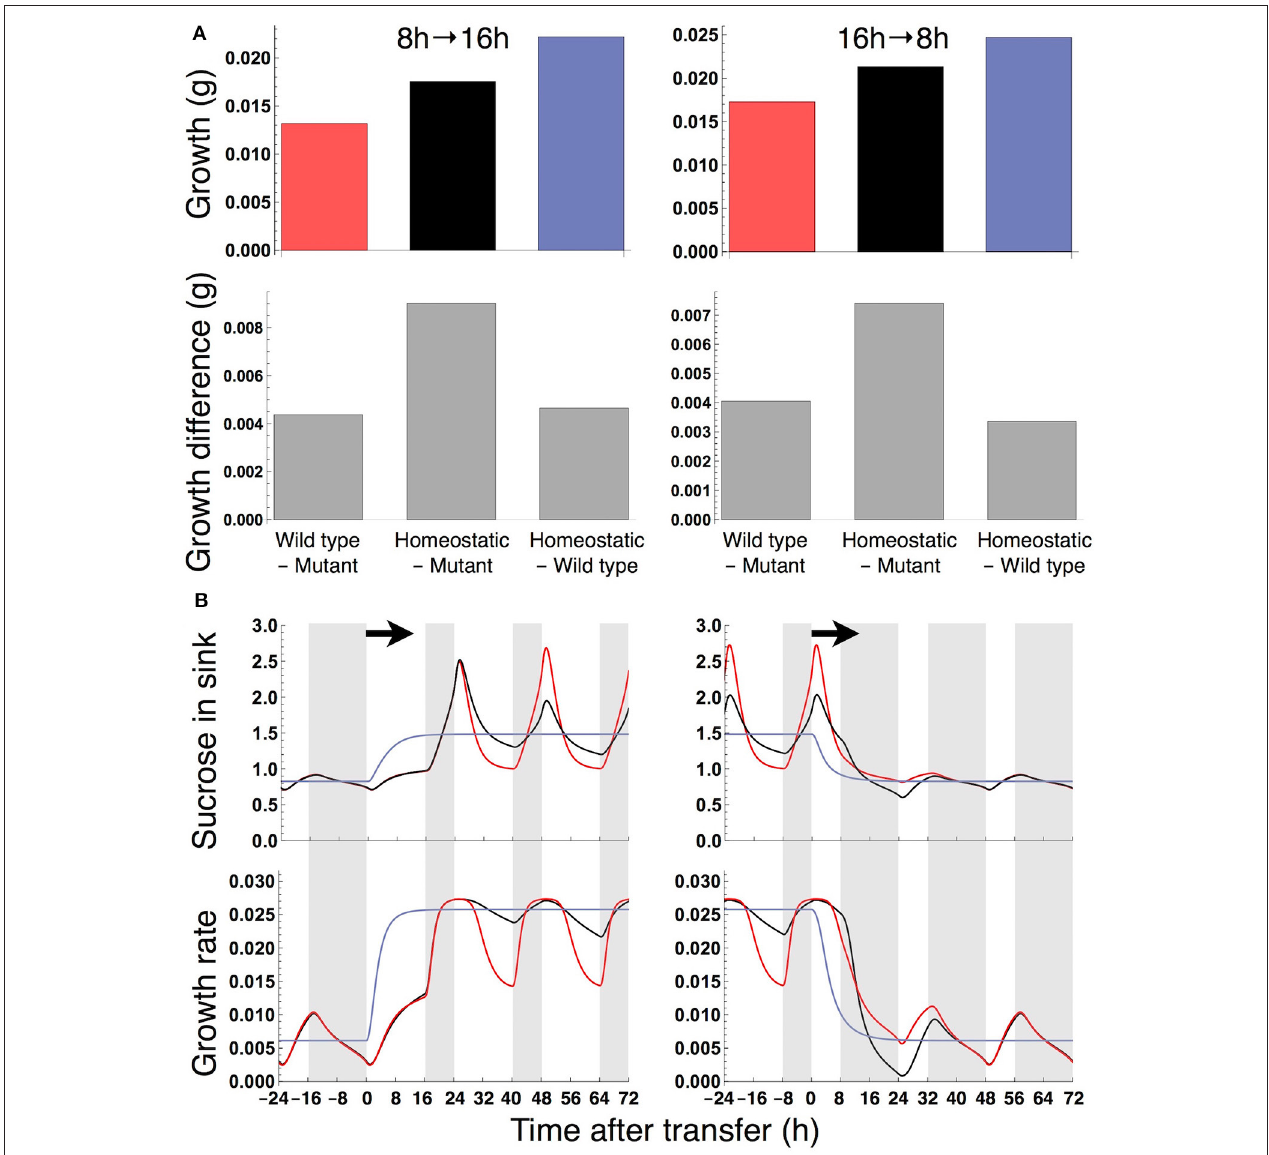
FIGURE 8 | (A) Growth of the sink (SAM or RAM) of the mutant, wild type, and homeostatic plant transferred from an 8-h to 16-h photoperiod (left) and from a 16-h to 8-h photoperiod (right) and the growth difference among the plants. Color codes as in Figure 3A . (B) Predicted profiles of sucrose in the sink and growth rate around the photoperiod change. Details are as in the legend to Figure 4